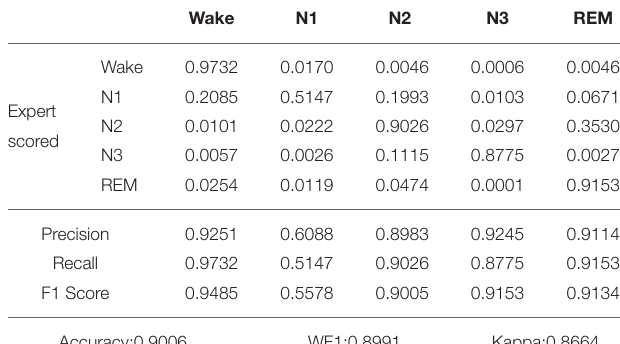
TABLE 3 | Confusion matrix and classification performance of proposed model applied on our own